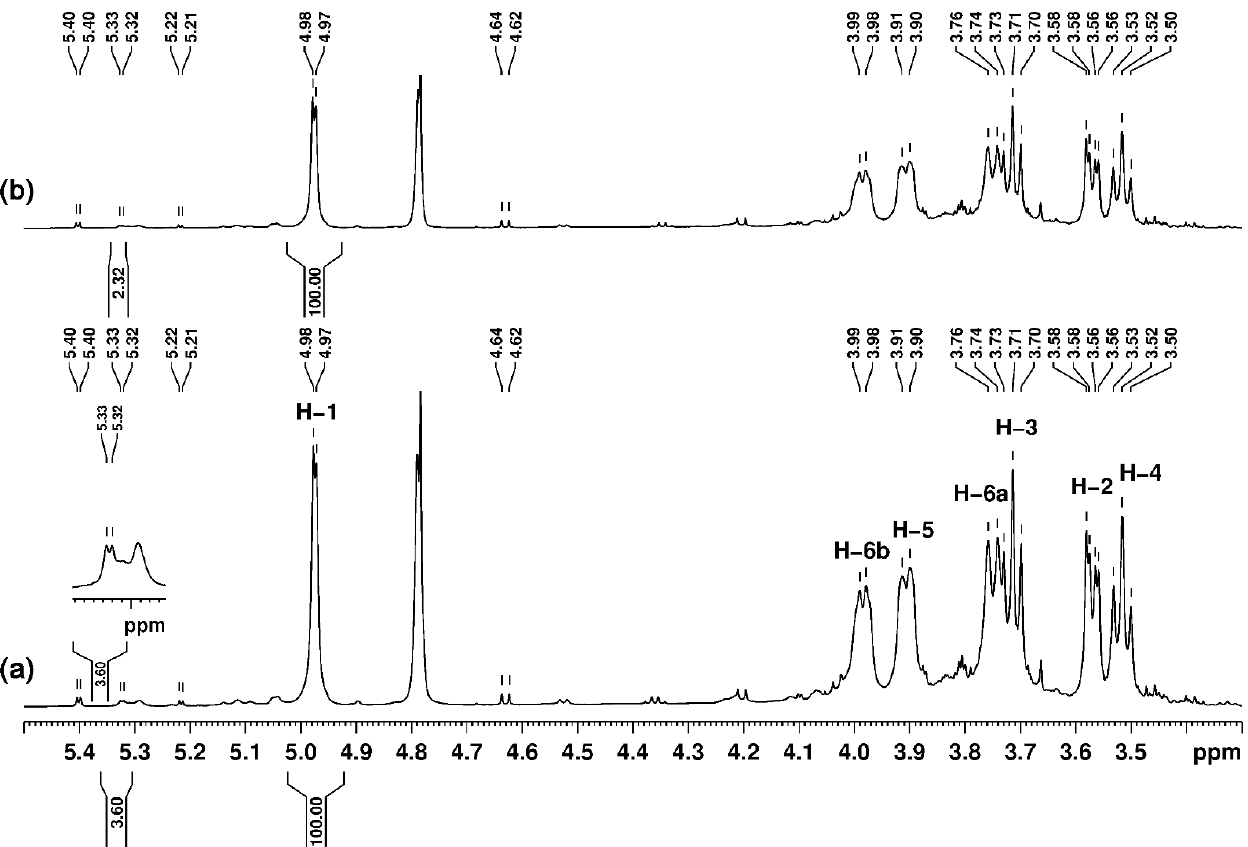
Figure 4. The overlap of the 1 H NMR spectra corresponding to the two analysed samples ( a ) M3C4 and ( b ) M3C5, recorded in D 2 O with water signal suppression. The signals’ assignments are annotated in the figure.